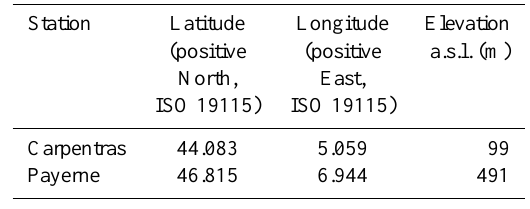
Table 1. Geographical coordinates of the two BSRN stations.